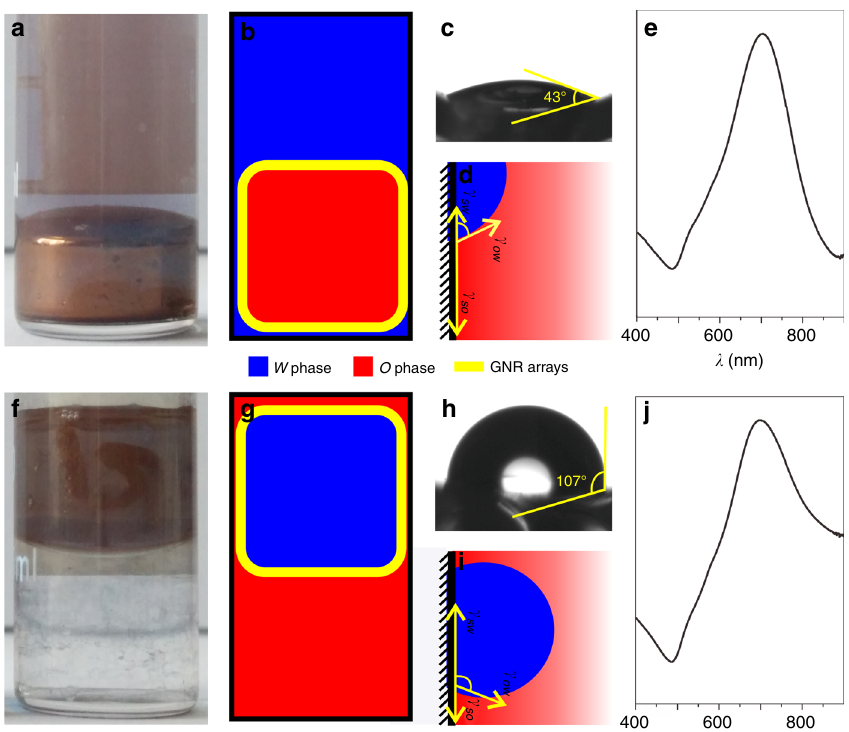
Fig. 3 Metal liquid-like self-ordered GNR arrays. a Optical image and b schematic of O -in- W encasing, c the corresponding water contact angle test, and d the hypothesized coexistence of S / O / W triple-phase boundary in a hydroxylated cuvette. f Optical image and g schematic of W -in- O encasing, h the corresponding water contact angle test, and i the hypothesized coexistence of S / O / W triple-phase boundary in fl uorosilylated cuvette. e , j UV – Vis absorbance spectra of GNR arrays on O -in- W and W -in- O interfaces,